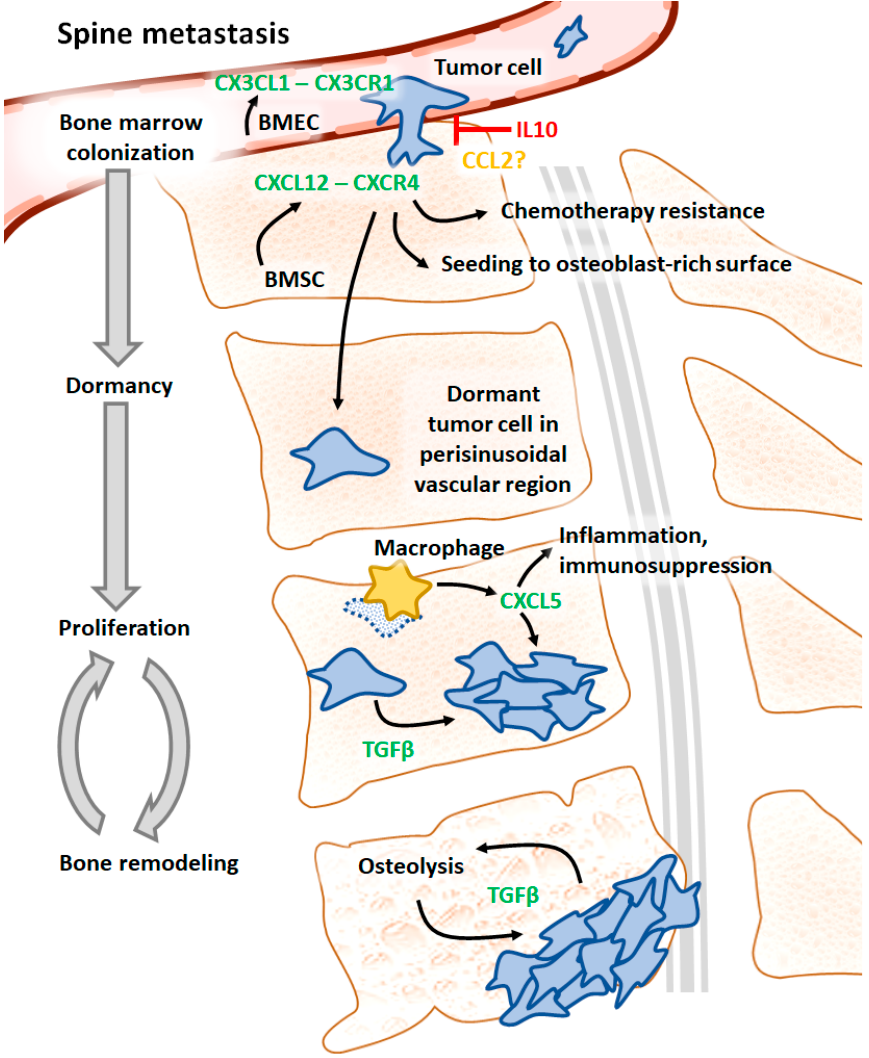
Figure 2. Involvement of cytokines across the stages of spine metastasis development. BMEC, bone marrow endothelial cells, BMSC, bone marrow stromal cells, CCL, CC motif chemokine lig- and, CX3CL, CX3C motif chemokine ligand, CX3CR, CX3C motif chemokine receptor, CXCL, CXC